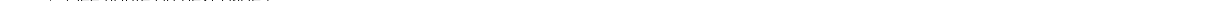
(See figure on next page.) Fig. 3 a Amber, plant fossil and glauconite pocket within shale indicated by yellow, blue and green arrows, respectively. b Granular amber within black shale. c Pyroclastics of unit 1. d Grey shale with amber (yellow arrow) and plant fossils (blue arrow) in unit 2. e Black shale with amber (yellow arrow) and plant fossils (blue arrow) in unit 2. f Grey shale with glauconite pocket (green oval) in unit 2. g Grey shale with pyrite (yellow oval) and plant matter (blue arrow) in unit 2. h Green shale in unit 3, glauconite indicated by green arrow; white dots are fragments of fossil molluscs. i Grey shale with pockets of glauconite and mollusc fragments in unit 3. j Green shale with pyrite (yellow arrow) in unit 3. k Shell limestone with mollusc fossils in unit 3; yellow and green arrows indicate Caestocorbula sp. and Claibornicardia sp., respectively. l Mollusc concentration in upper part of unit 3. m Black shale with plant fossil (blue arrow) in unit 4. n Lignite in unit 4. o Ferricrete in unit 4. Scale bars 10